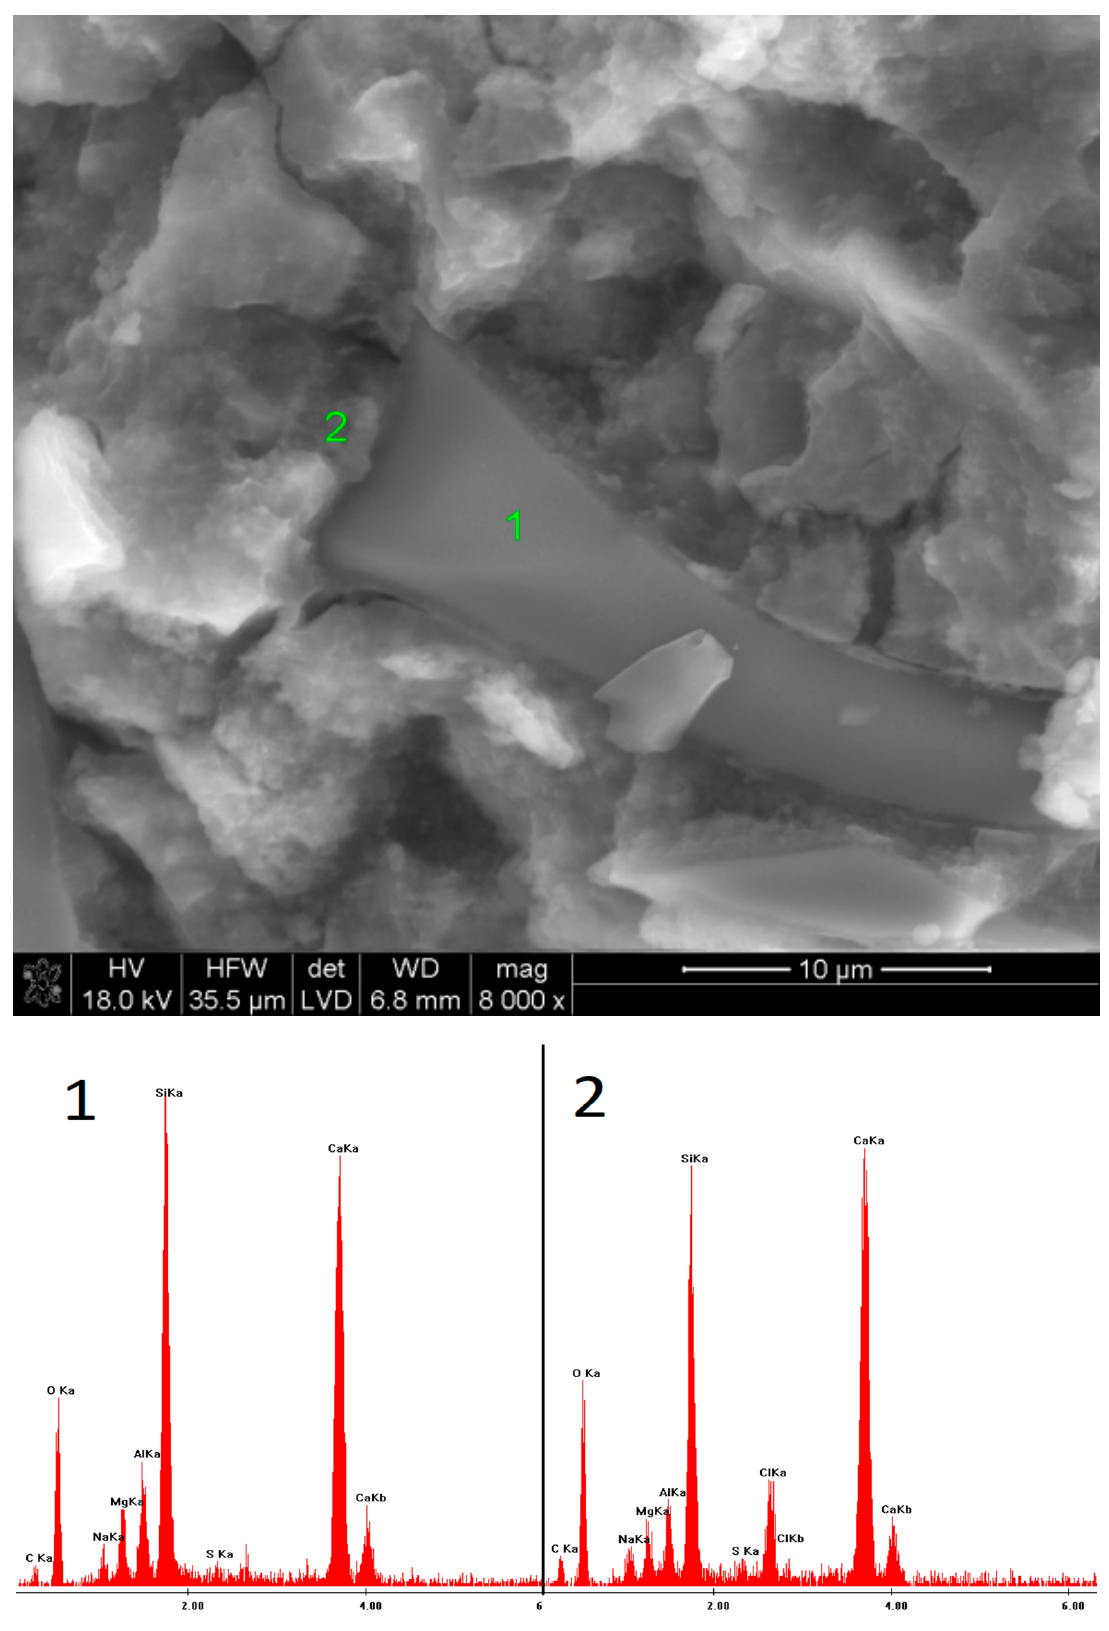
Figure 19. Microstructure of slag paste activated with sodium chloride after 40 days of